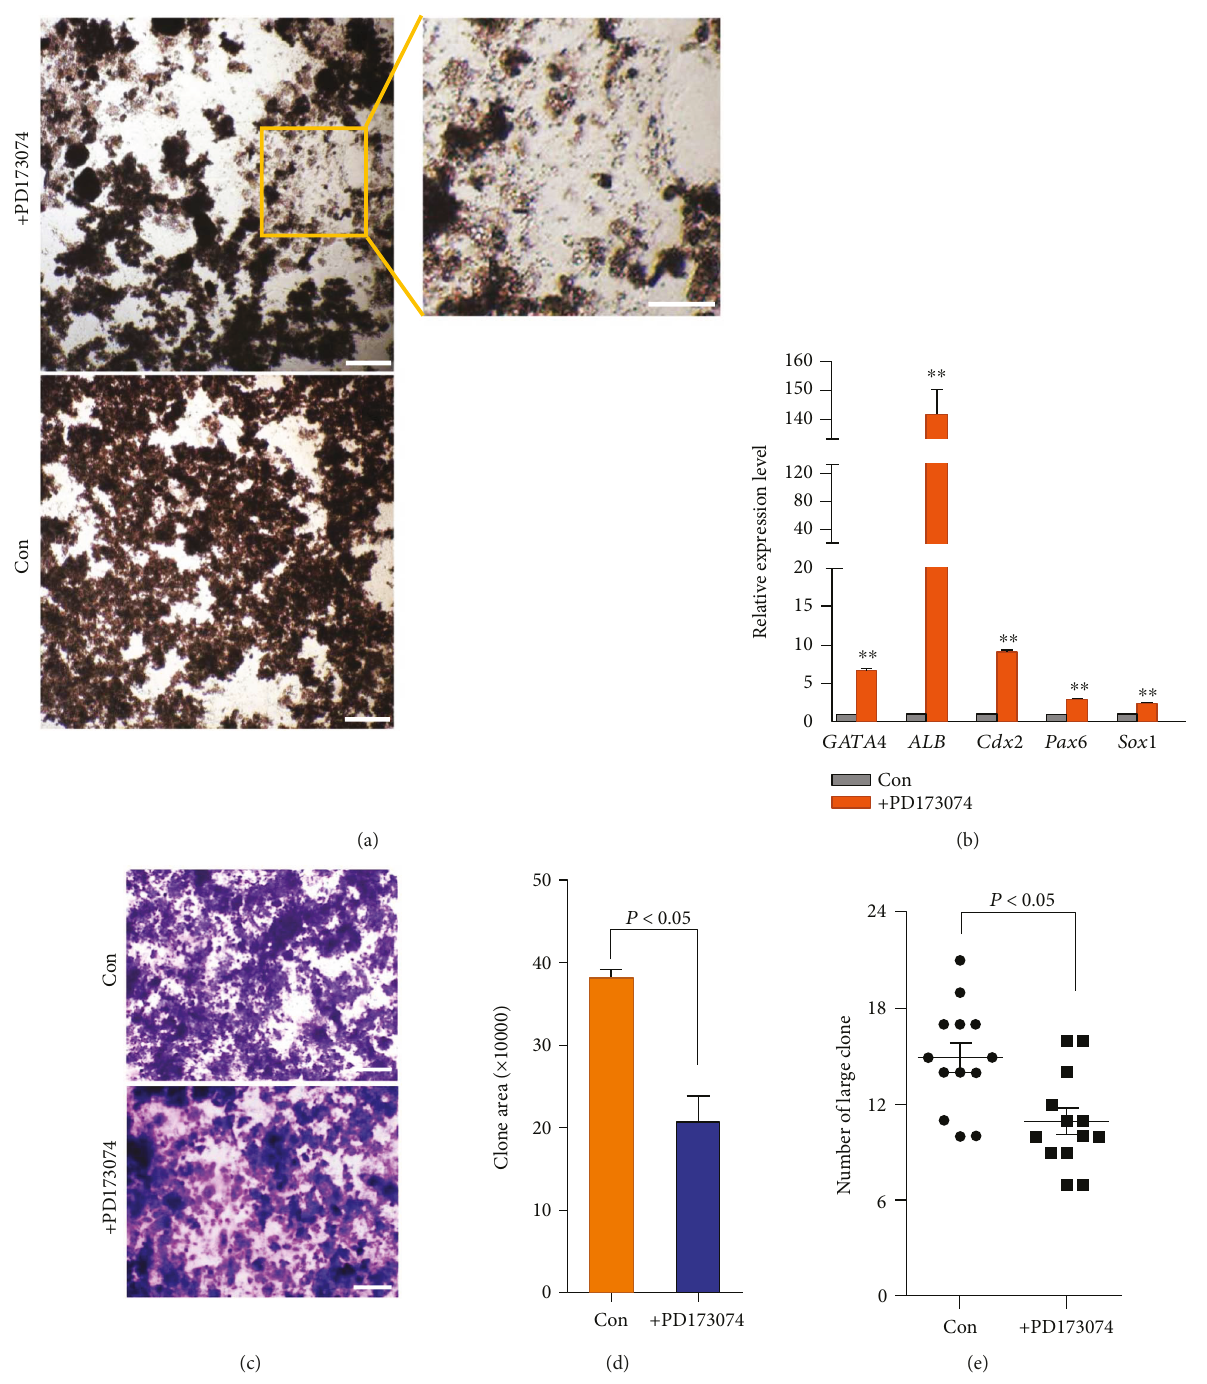
Figure 2: bFGF inhibits the di ff erentiation of cESCs in vitro . (a) The inhibition of FGFR1 promoted the di ff erentiation. The primary cESCs in the complete medium were treated with an e ff ective FGFR1 inhibitor PD173074. Di ff erentiated cells were highlighted in the yellow box. (b) The inhibition of FGFR1 led to an increase in the mRNA level of three germ layer marker genes. ∗∗ implies: compared to control group, there is a extremely remarkable di ff erence ( P < 0 01 ). Quantitative RT-PCR of GATA4, ALB, CDX2, PAX6, SOX1, and β -actin was performed. (c) The inhibition of FGFR1 suppressed the formation of the clone. Crystal violet staining of primary cESCs in